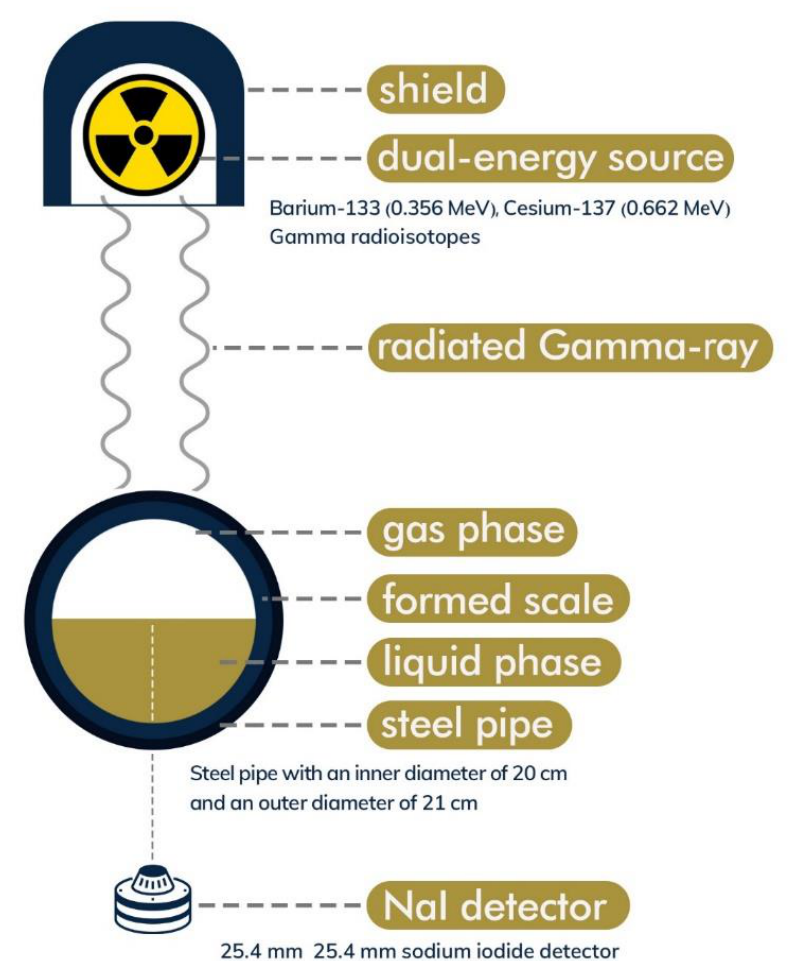
Figure 2. The detection system, respectively, from top to bottom: source shield, dual energy source, radiated gamma ray, gaseous phase, scale formed, liquid phase, steel pipe, NaI detector.